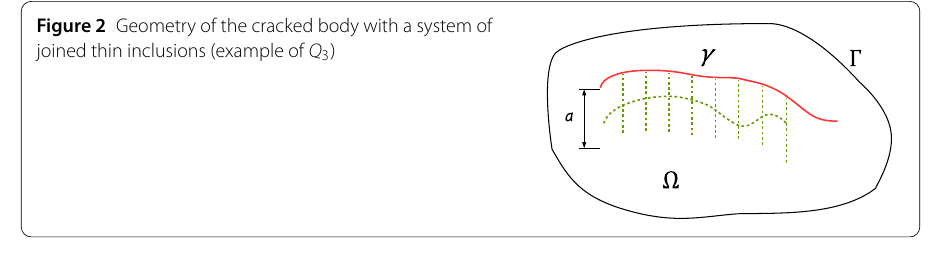
defined by the function ψ ∈ C 0,1 [0,1]